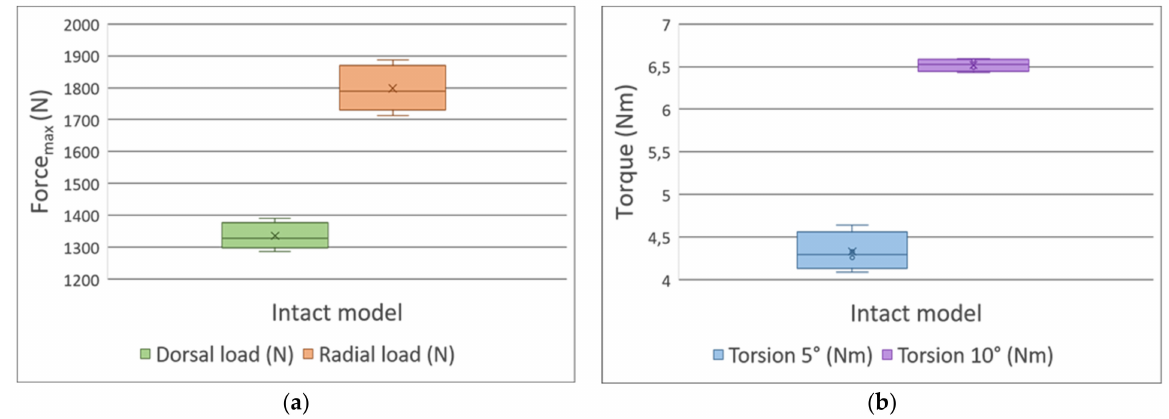
Figure 7. Box plots of the ( a ) three-point bending and ( b ) torsion tests regarding the intact bone models. The radial, dorsal loads, and the 5 ◦ and 10 ◦ torsions are coded using various colors.